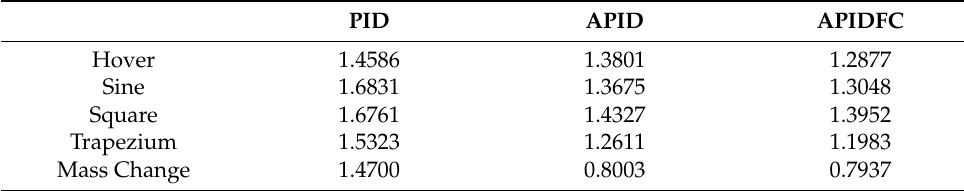
Table 4. Experiment performance index for PID, APID, and APIDFC.